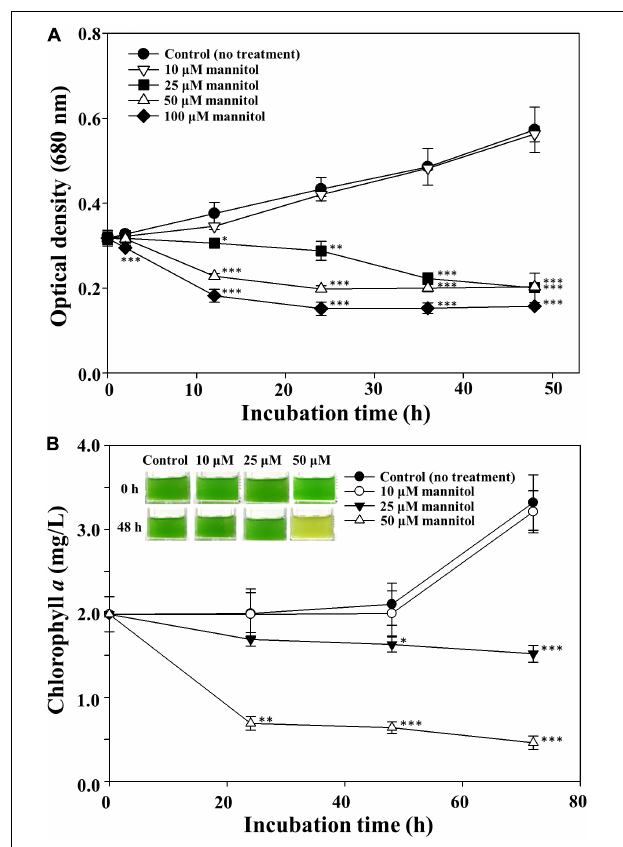
FIGURE 3 | Optical cell density (A) and chlorophyll a (B) profiles of Microcystis aeruginosa NIES-298 treated with different concentrations of mannitol. Data are indicated as mean values ± standard deviations. Images showing the color changes of cell cultures after mannitol treatment are also displayed in (B) . Statistical significances depending on the mannitol treatments were calculated compared to the control group (no treatment) and their significant differences were indicated with p -values < 0.05 ( ∗ ), < 0.01 ( ∗∗ ), or < 0.001 ( ∗∗∗ ).